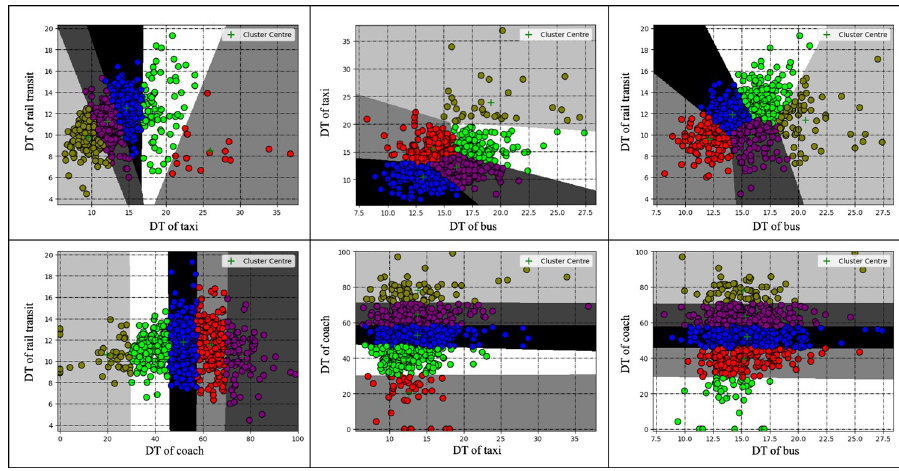
Fig 8. DT cluster analysis results.